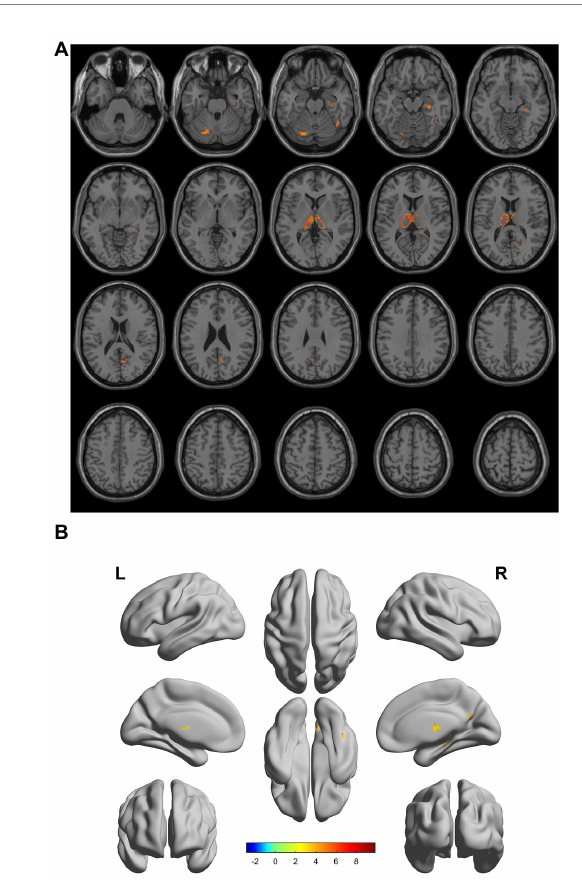
FIGURE 3 (A, B) Compared with the normal control group, the distribution of gray matter atrophy changed in the subcortical ischemic vascular disease- vascular dementia group. Orange-yellow shows the areas of difference.